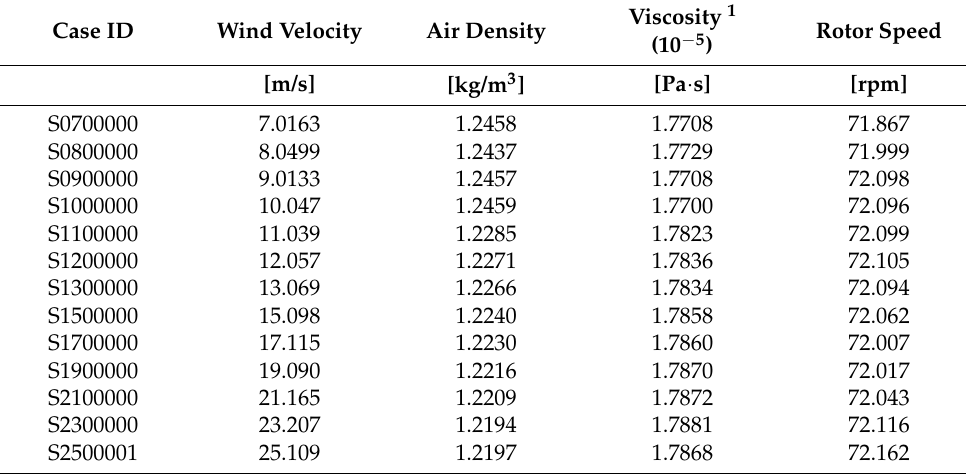
Table 1. Computational